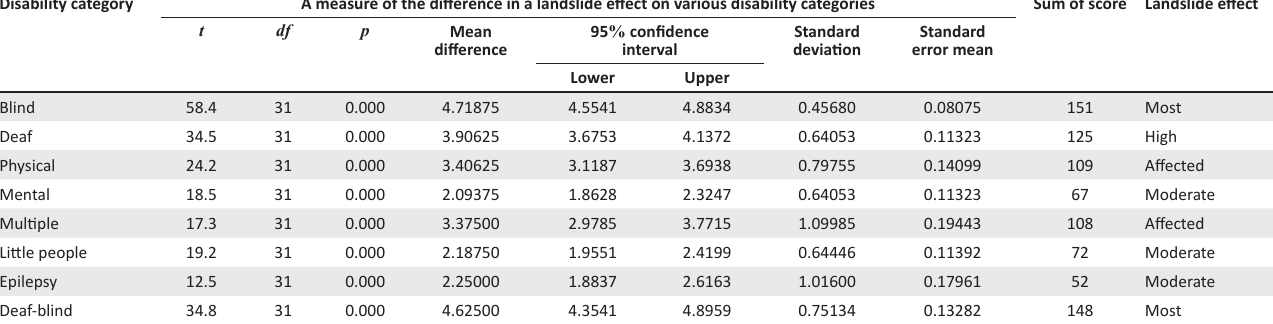
FIGURE 2: Landslide that occured following a heavy downpour in the night 14, Oct 2021, affecting 214 (33 households) and displacing 65 people in Nakhatore village, Bududa TABLE 2: Summary of the perceived landslide effect on disability categories. Disability category